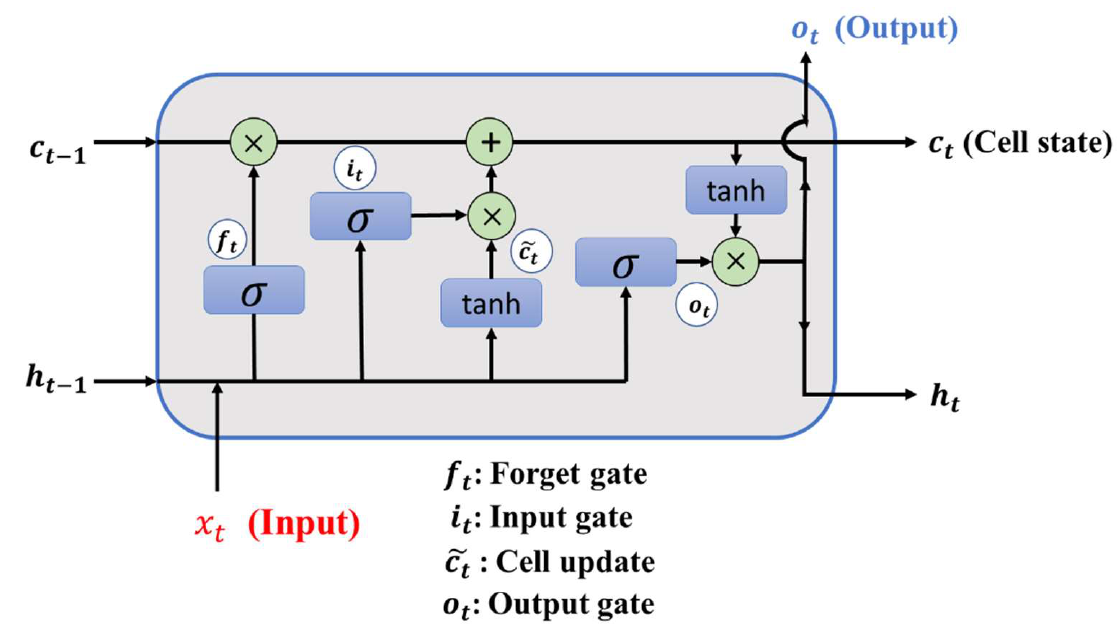
Figure 7. Complete architecture of LSTM.